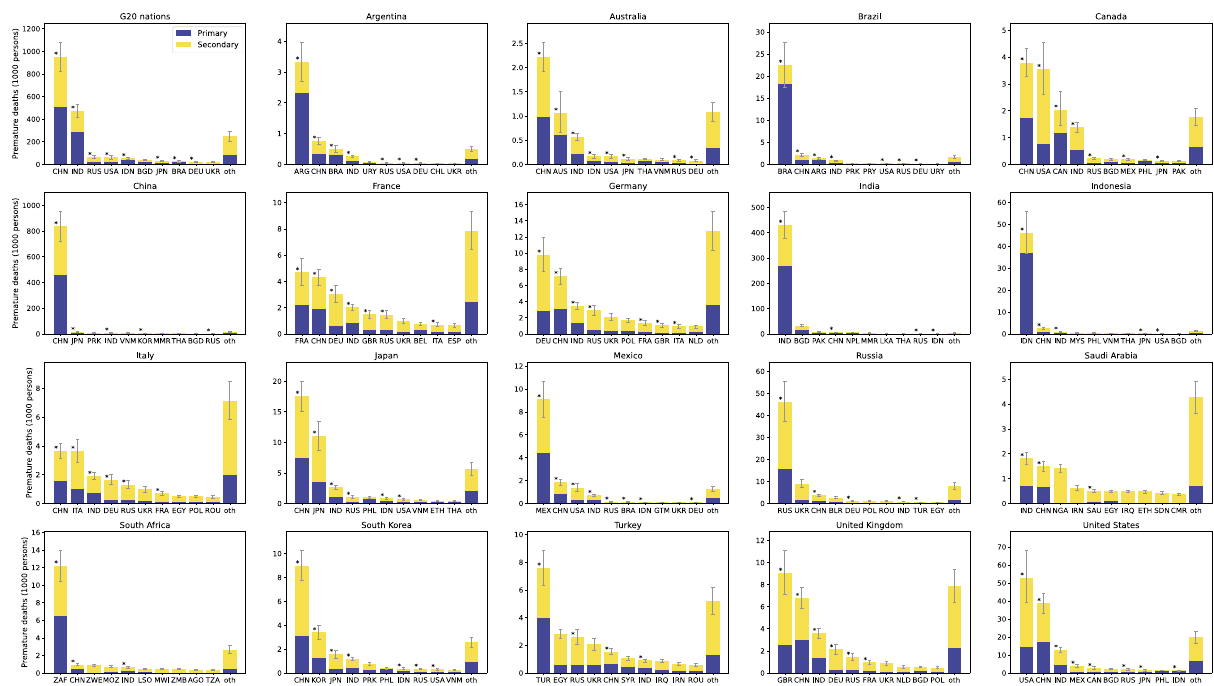
Fig. 2 Breakdown of PM 2.5 premature death footprint of G20 nations by impacted country and contribution of primary and secondary particles to footprint. Asterisks above bars indicate G20 nations with presidency rights. Country and region codes within the top 10 are as listed in Supplementary Table 1 in the Supporting Information; others are aggregated as ‘ oth ’ . Error bars indicate 95% con fi dence intervals. The centre of the bars indicates the mean